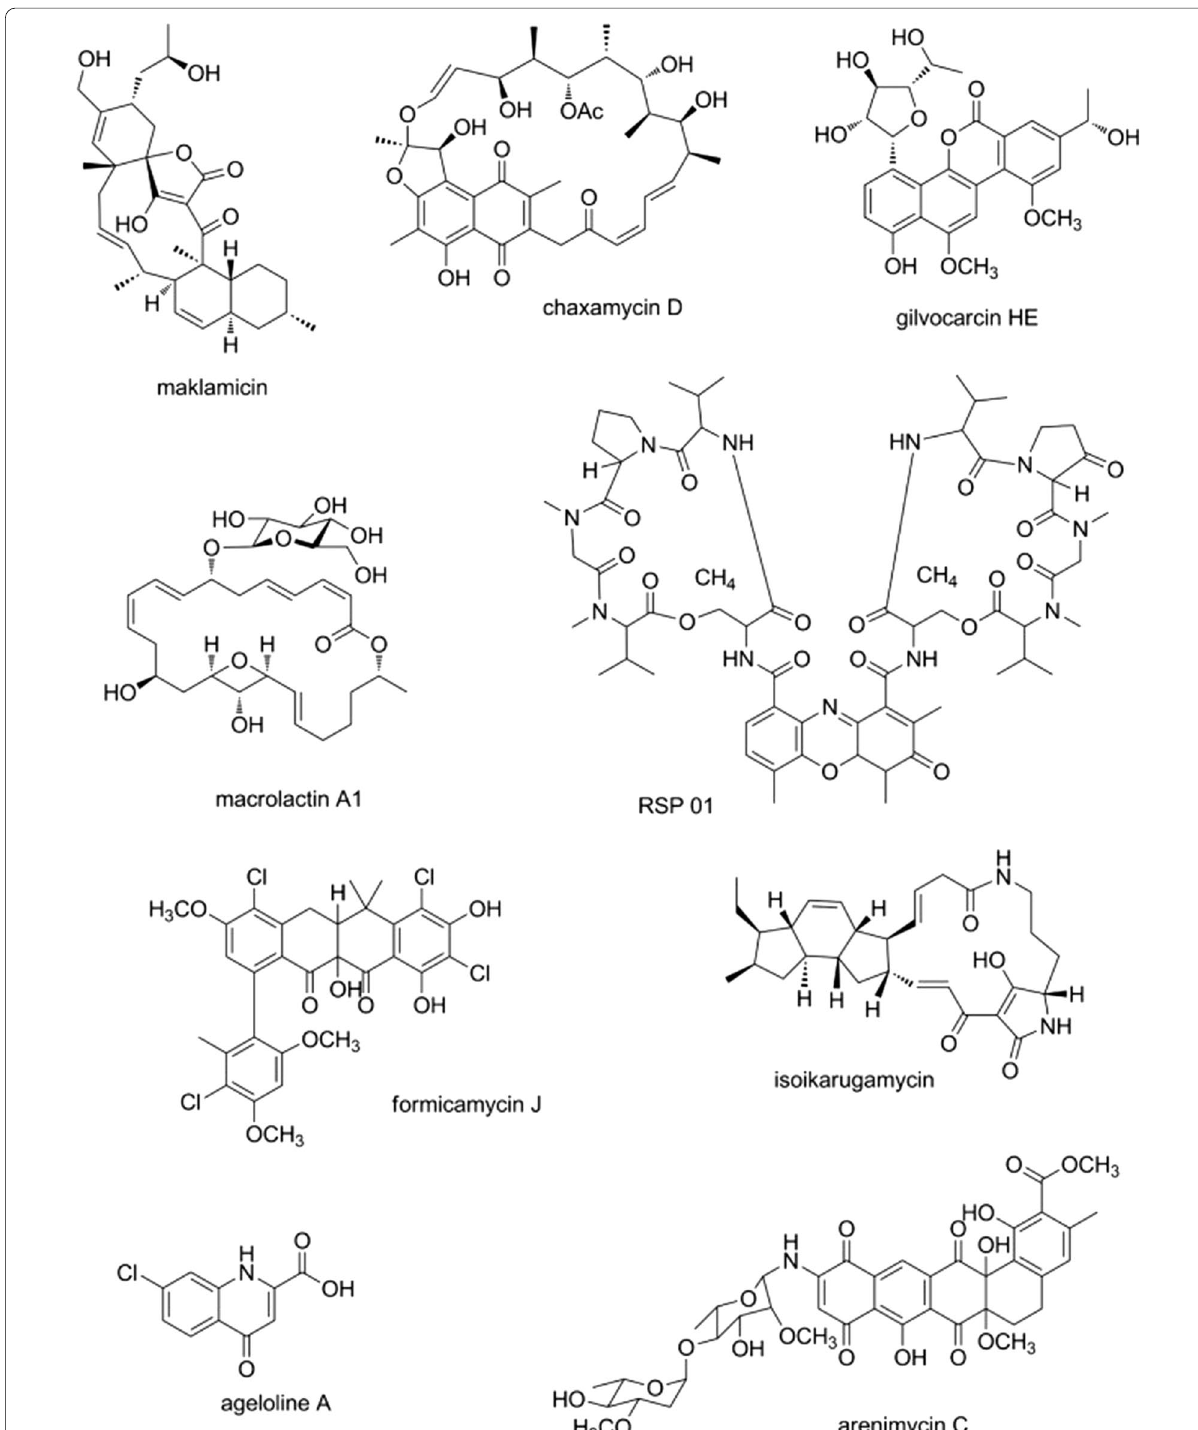
Fig. 1 Chemical structures of some bioactive compounds from rare